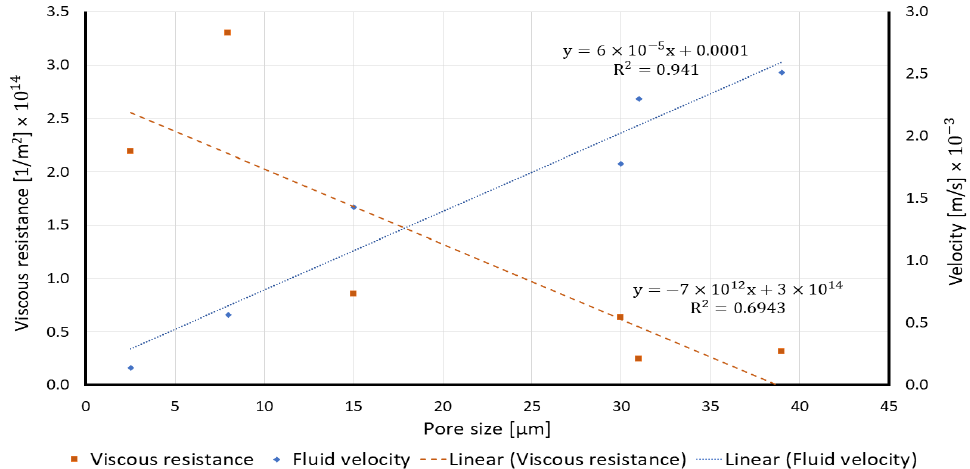
Figure 2. Effect of the pore size on the viscous resistance and fluid velocity in porous media.